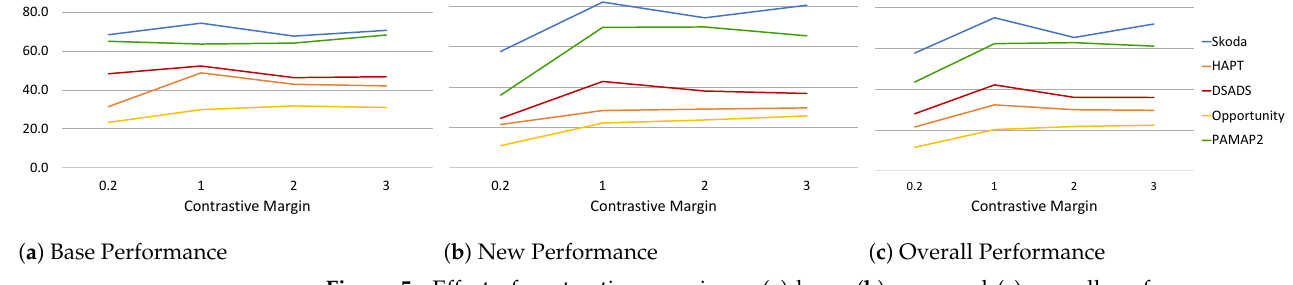
Figure 5. Effect of contrastive margin on ( a ) base, ( b ) new, and ( c ) overall performance across all datasets.